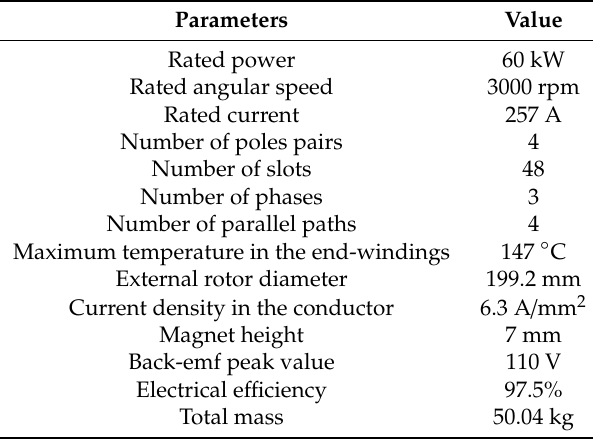
Table 3. Motor obtained with the optimization.